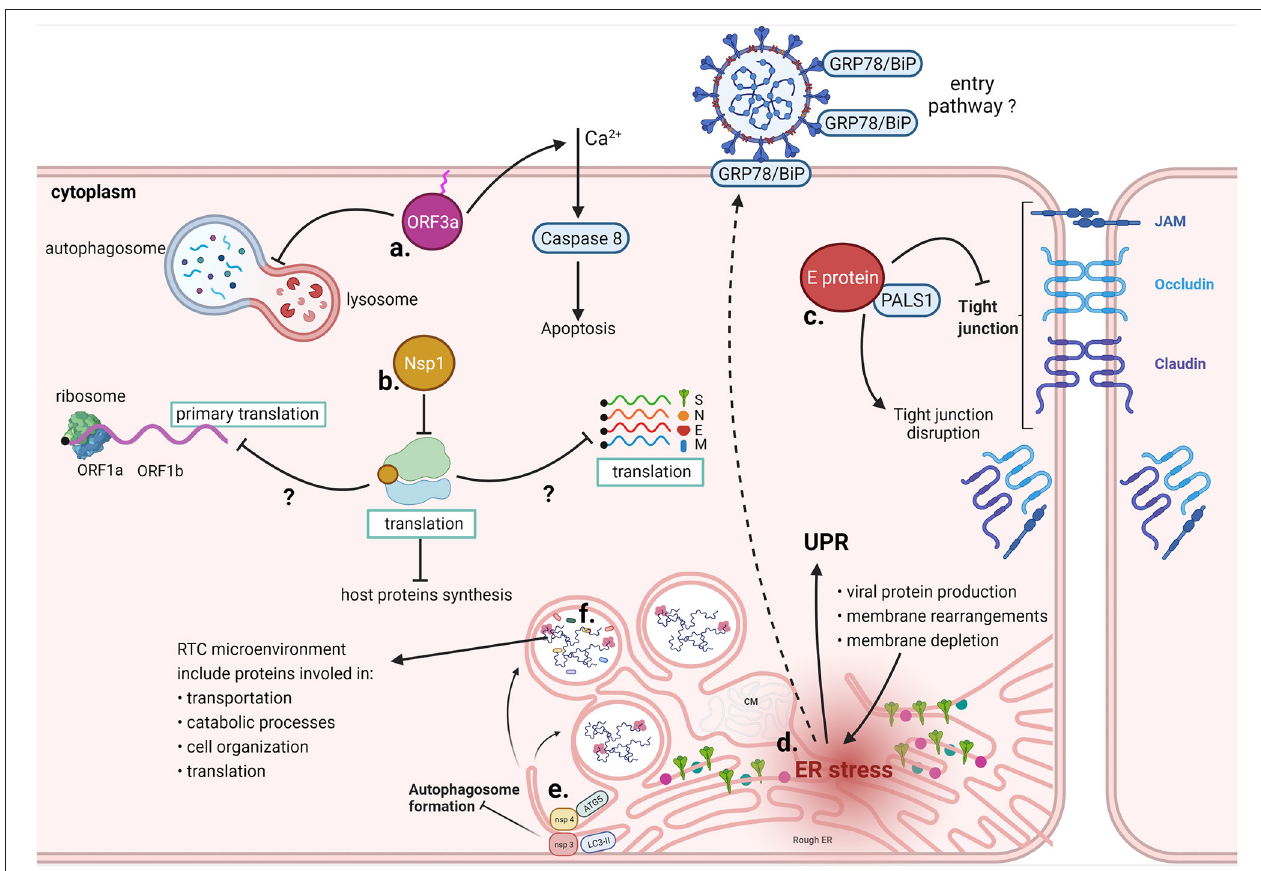
FIGURE 8 | Cytoplasmic interactions of SARS-CoV-2. a. ORF3a requires binding to the plasma membrane to promote Ca 2 + -dependent apoptosis and prevents autophagosome-lysosome fusion. b. Nsp1 sterically occludes the mRNA entrance channel of the ribosome, prevents the physiological conformation of 48S PIC, and reduces mRNA transport through the NPC. Molecular mechanisms whereby Nsp1 specifically blocks only host translation have yet to be clarified. c. Computational predictions indicate that SARS-CoV-2 E protein binds to PALS1, normally involved in tight junctions maintenance, leading to their disruption. d. Excessive viral protein production, membrane rearrangements leading to the formation of DMVs and membrane depletion due to virus budding from ERGIC contribute to ER stress, which results in the UPR. Prolonged ER stress induces missorting of GRP78/BiP to the cell membrane, likely increasing infectivity upon binding of the chaperone with the SARS-CoV-2 spike protein. e. Nsp3 and Nsp4 prevent the formation of autophagosomes by inducing the formation of DMVs; ATG5, LC3 and other cellar factors involved in the autophagosome formation colocalize with the non-structural proteins. f. Different host proteins have been identified in the RTC microenvironment, including proteins involved in transportation, catabolic processes, cell organization and